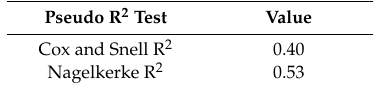
Table 3. Pseudo R 2 Test of the logistic model with 13 predicting factors.